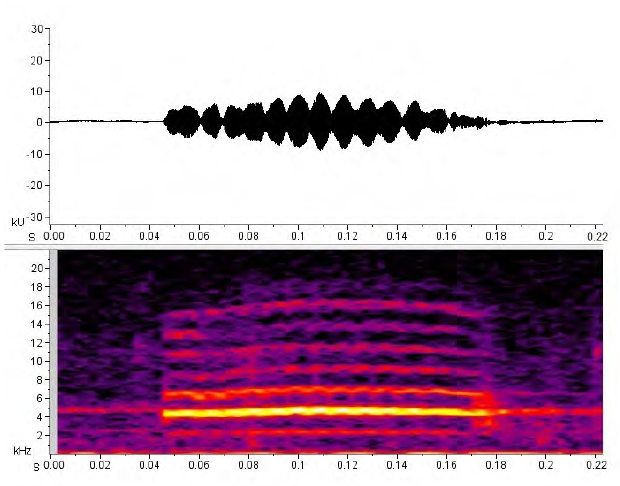
Adenomera thomei . Oscillogram and spectrogram of the advertisement call of from southern Minas Gerais state, voucher depicted in Figure 1 (Voucher CHARW